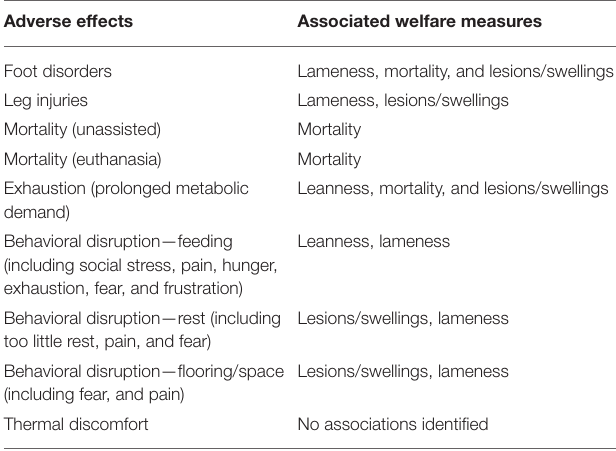
TABLE 2 | Summary of which of the “worst adverse effects” for dairy cattle welfare are associated with the selection of welfare measures in the current study based upon Nielsen et al.